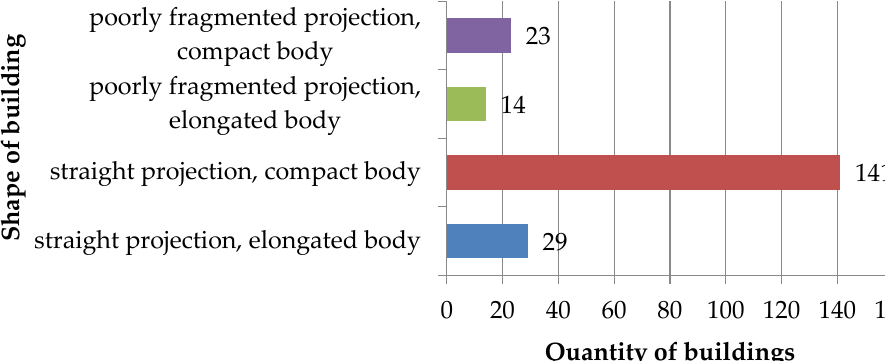
Figure 11. Distribution of data for the variable relating to the number of storeys.